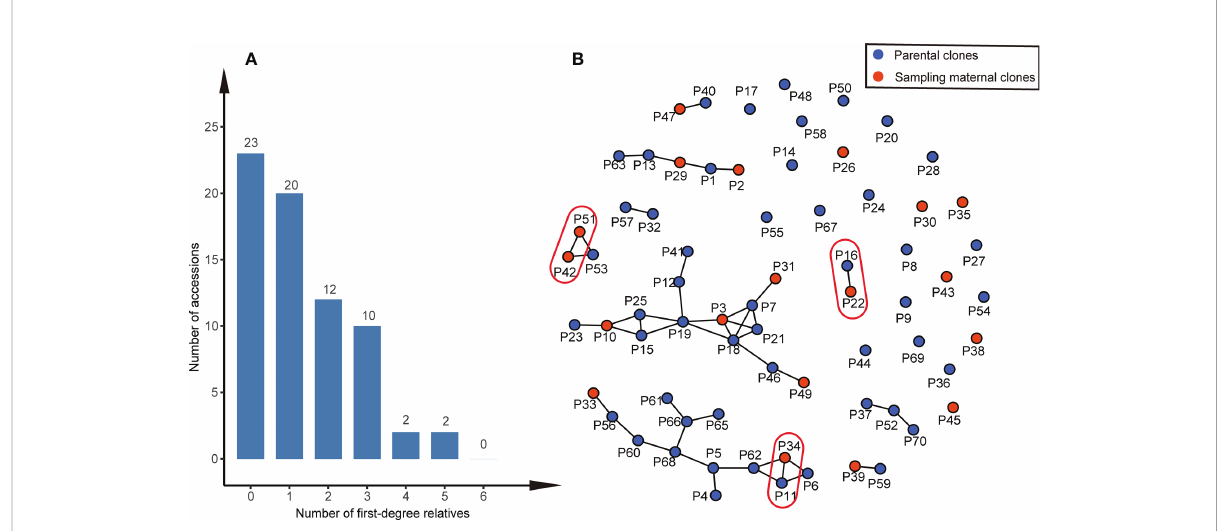
FIGURE 2 First-degree relationships within the Chinese fi r germplasm collection. (A) Histogram of the number of fi rst-degree relatives in the thirdgeneration seed orchard of Chinese fi r. (B) A network of parental clones shows connections between fi rst-degree relatives. The T (TrioML) of the parental clones in the red oval was one, and they were considered clones of one another.